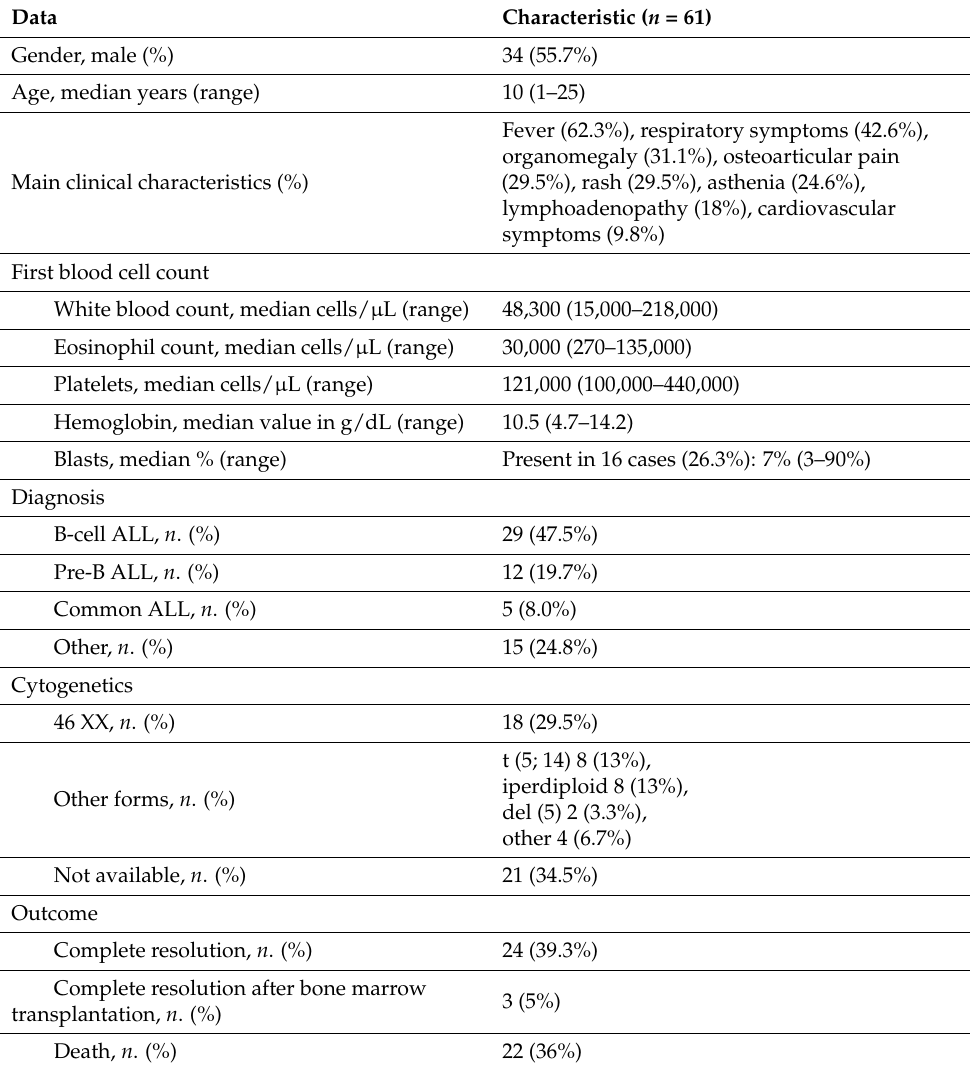
Table 1. Characteristics of the cases reported in the literature from 1973–present of acute lymphoblastic leukemia (ALL) with hypereosinophilic onset in patients younger than 25